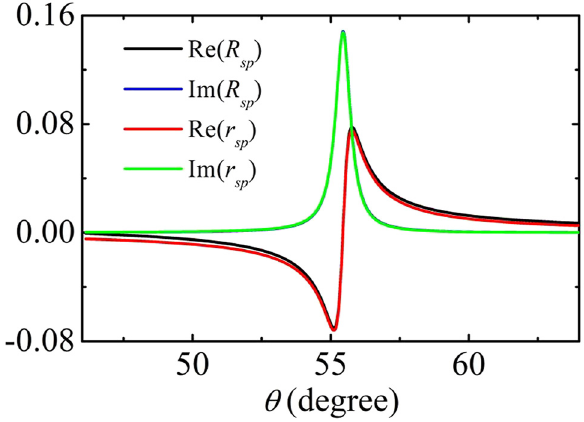
calculated by the method in Figure 6: The comparison of reflection r sp Section 1 of the Supplementary material and R calculated by Eq. (17). sp = 100 nm, and d = 150 Here, 𝜅 = 0.5, d m c